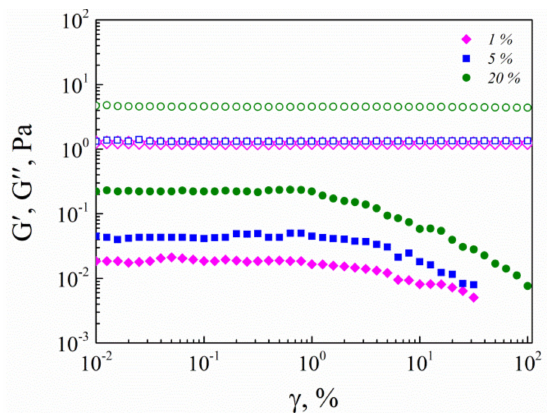
Figure 9. Amplitude dependences of the storage modulus G (cid:48) (filled symbols) and loss modulus G” (open symbols) at 30 ◦ C, ω = 6.28 s − 1 . Aqueous phase volume fractions of emulsion are shown on the plot.